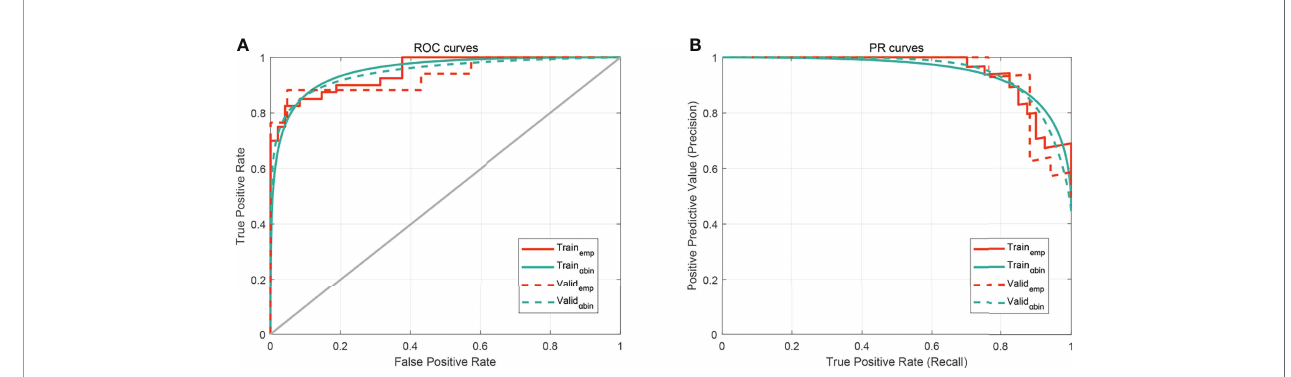
FIGURE 6 | The performance of the developed nomogram. (A) Receiver operating characteristic (ROC) curves. (B) Precision – recall curve (PRC). The subscripts emp and a bin mean empirical and a -binormal-based ROC or PRC, respectively.